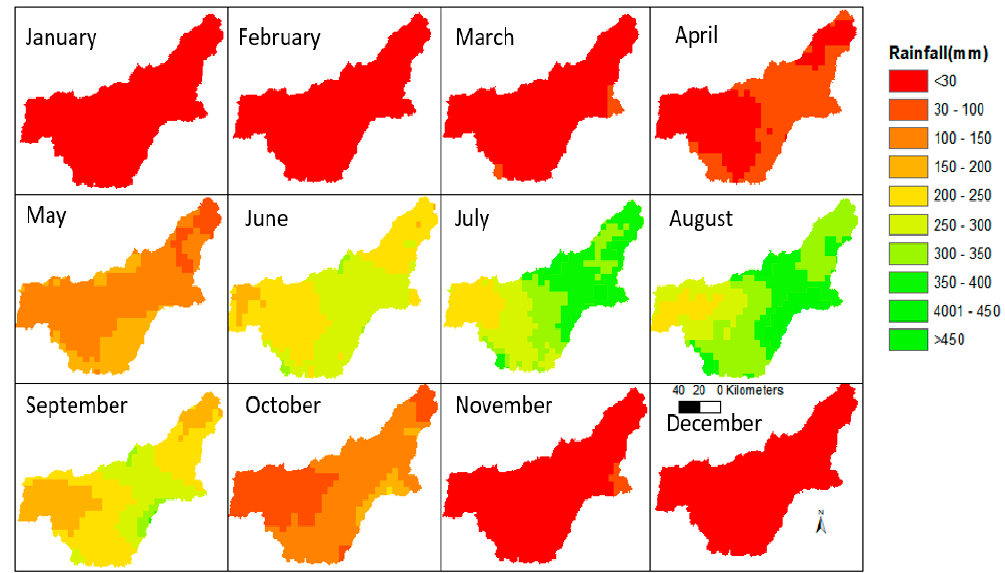
Figure 10. Spatial distribution of long-term mean monthly rainfall of the Beles Basin (1981–2017).